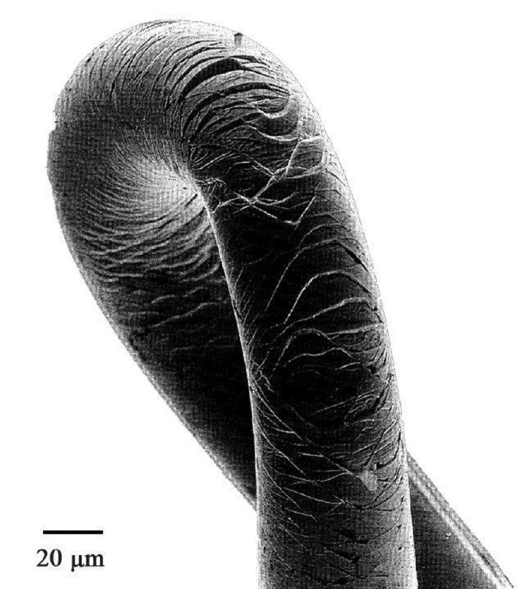
Figure 4. Scanning electron micrograph revealing the deformed structure of an Al Ni Ce wire which was bent through 180 degrees 14 . 85 10 5